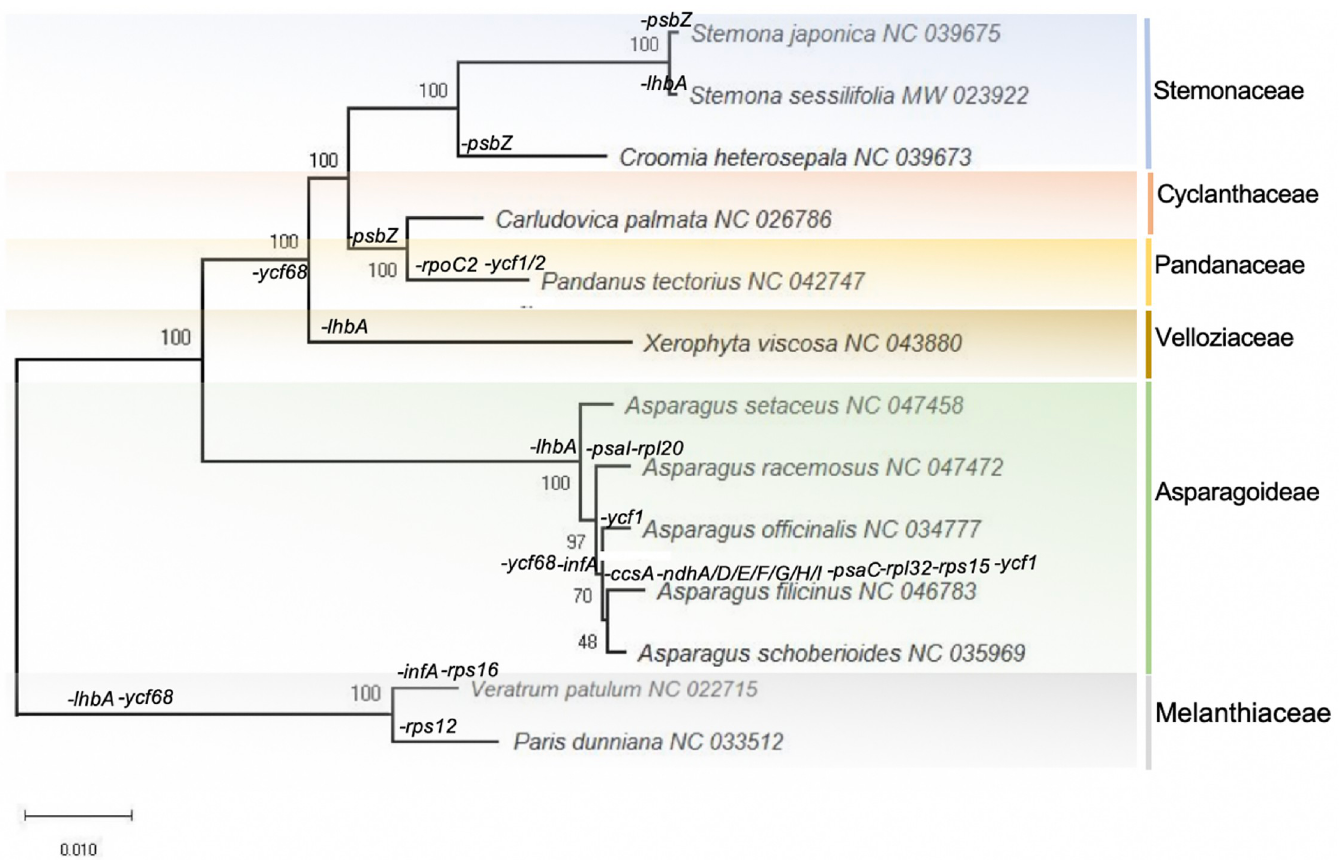
Fig 6. Molecular phylogenetic analysis of Pandanales and its closely related orders. The tree was constructed with 58 protein sequences presented in 116 species using the Maximum Likelihood method and implemented in RAxML with Nicotiana tabacum and Solanum lycopersicum serving as the outgroups. The numbers associated with the nodes indicate bootstrap values tested with 1000 replicates. The orders and families to which each species belongs are marked beside the branches as well as the occurrence of gene loss events.